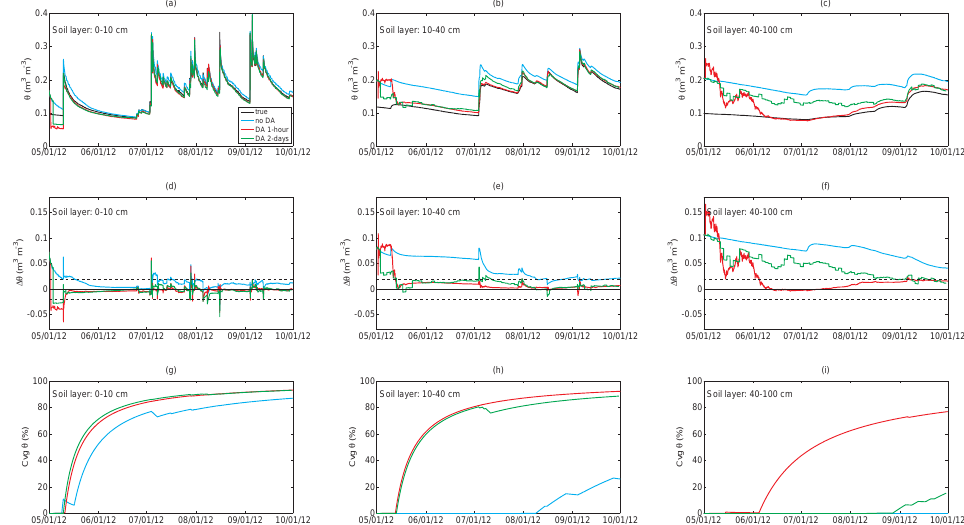
Figure 6. Comparison of soil moisture dynamics at the Kendall site for the first three soil layers in Noah. Top row: simulated soil moisture ( θ) without (no DA) and with data assimilation, characterized by low- and high-frequency retrievals (respectively, DA 2-day and DA 1-hour) compared to the true soil moisture states. Middle row: the difference between simulated soil moisture and the true states ( 1θ) within pre- defined uncertainty ranges (dashed black lines). Bottom row: convergence criterion within uncertainty ranges. Results show actual model time steps (i.e., hourly). The ensemble mean of the prior distribution is shown for all ensemble simulations. Table 4. Summary of statistics computed for Noah for assimilation of synthetic neutron intensity measurements for all sites. All metrics are calculated only when individual layer convergence is above 40% for the case DA 1-hour (see bottom panel of Figs. 6, 7, and 8), and with respect to the true soil moisture state. The ensemble mean of the prior distribution is used for all ensemble simulations. Numerical values are rounded to the first three decimal